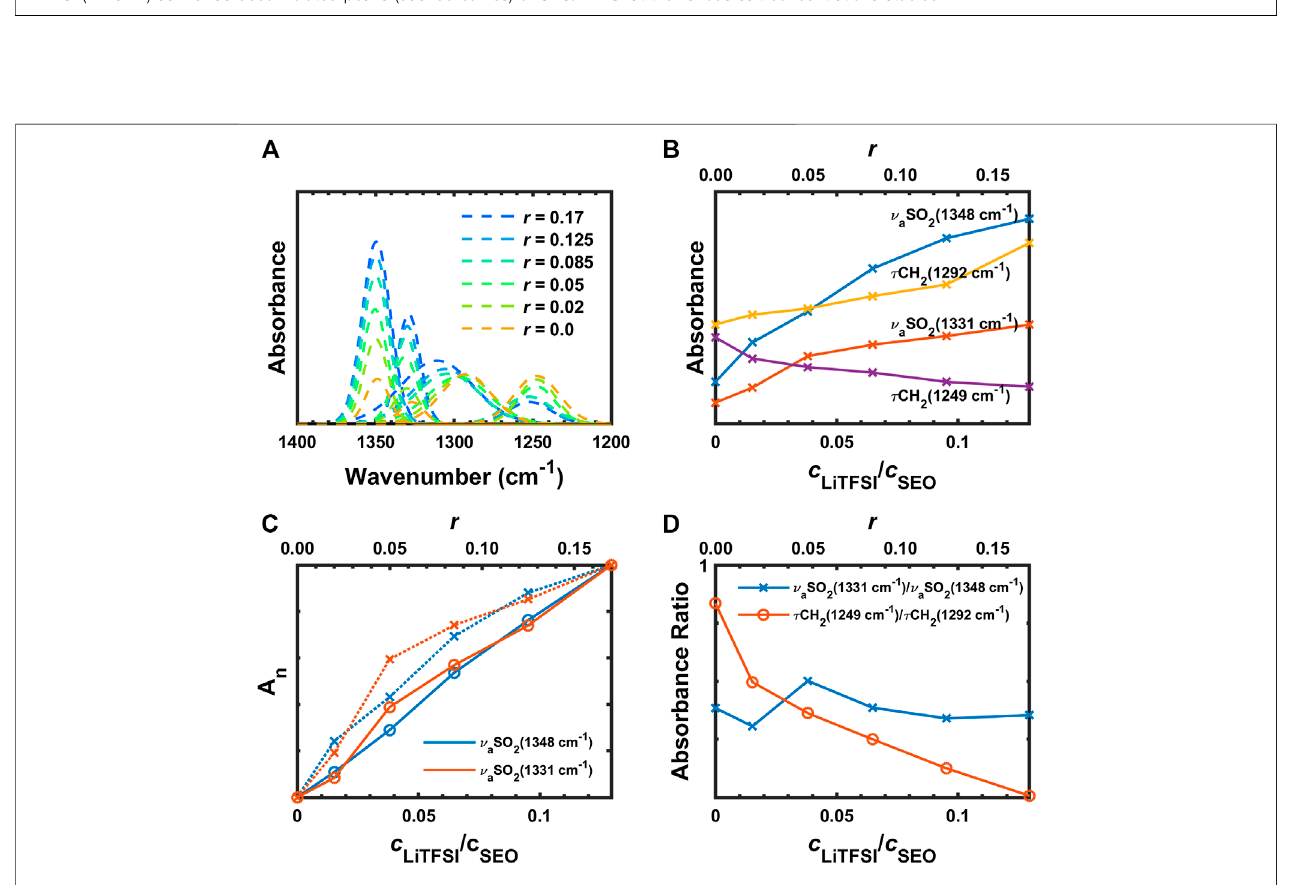
FIGURE 4 | (A) Deconvoluted peaks of IR bands from 1,400 to 1,200 cm − 1 , (B) absorbances of ] a SO 2 and τ CH 2 , (C) normalized absorbances of ] a SO 2 [ ···×··· A n , − 1 )], and (D) ratios of ] ─ ○ ─ A ] ] τ CH a SO 2 (1,348), red: a SO 2 (1,331 cm a SO 2 and 2 peaks. c , n , blue: